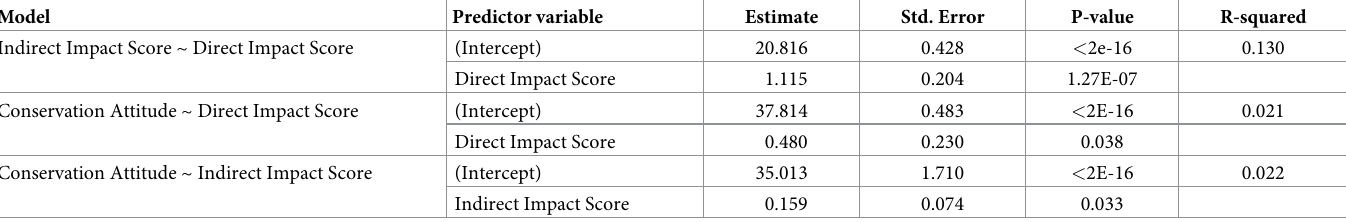
Table 7. Effects of direct and indirect impacts on conservation attitude in the Bago-Yangon and Ayeyarwady regions of Myanmar (May 2017-December 2018) based on the linear regressions from responses of the 203 participants who answered all applicable Likert statements.